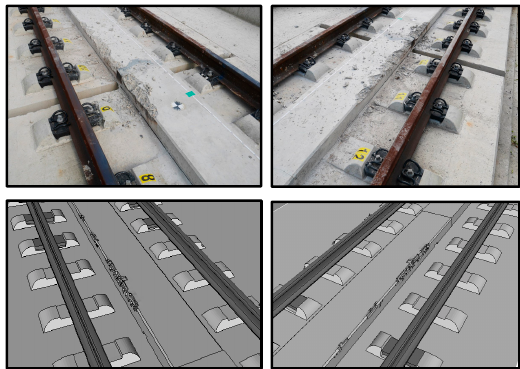
Figure 22. Comparison of location of broken DCP.